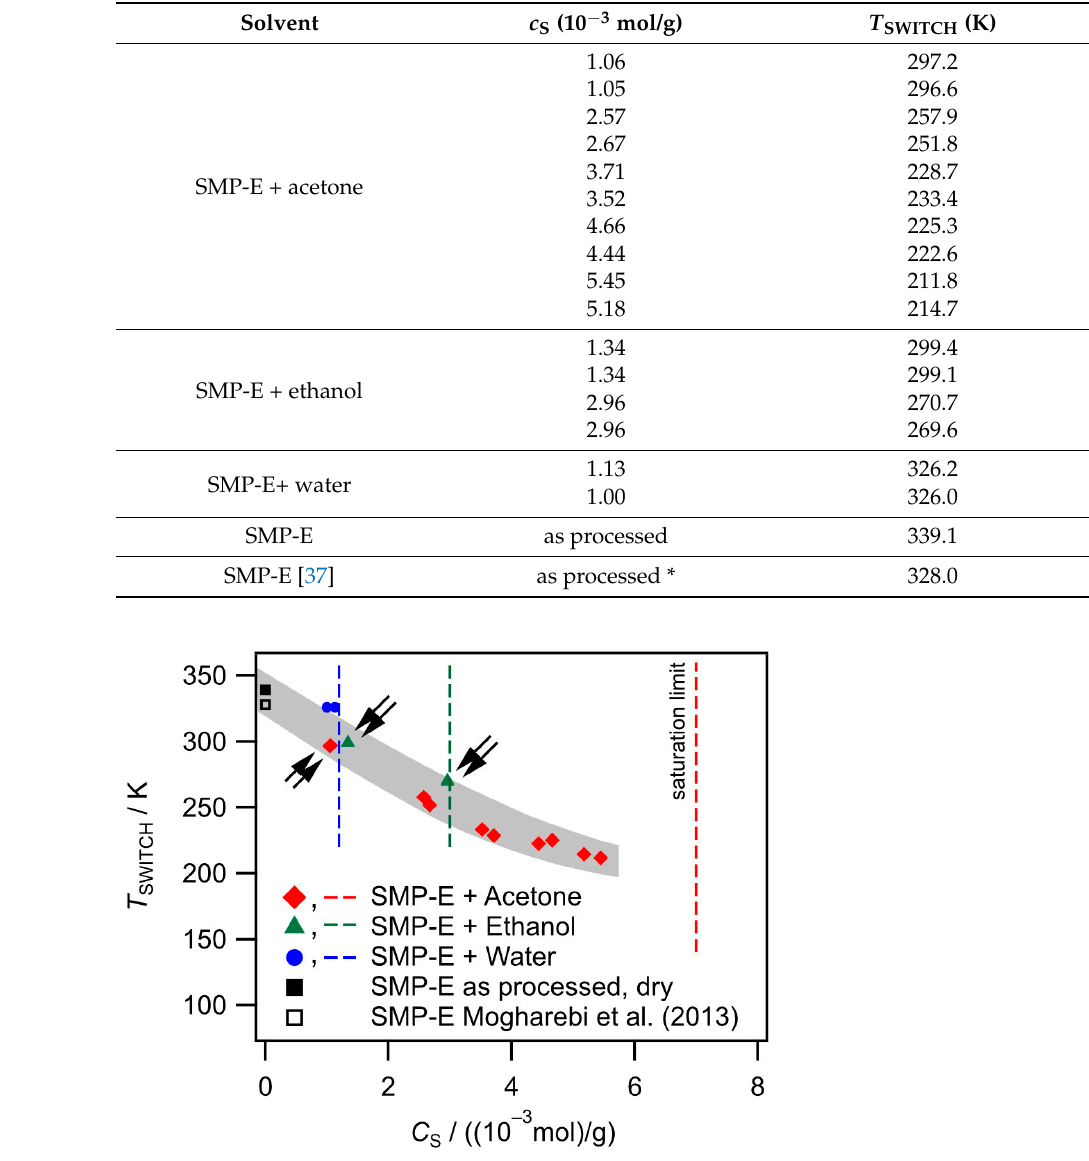
Table 4. Compilation of solvent concentrations (for as-processed material: 0) and corresponding temperatures T SWITCH of as-processed and chemically exposed SMP-E material states (* in 2013, Mogharebi et al. [37] used the same granulate as we used in the present work, albeit without drying steps; it seems likely that their material took up some humidity).